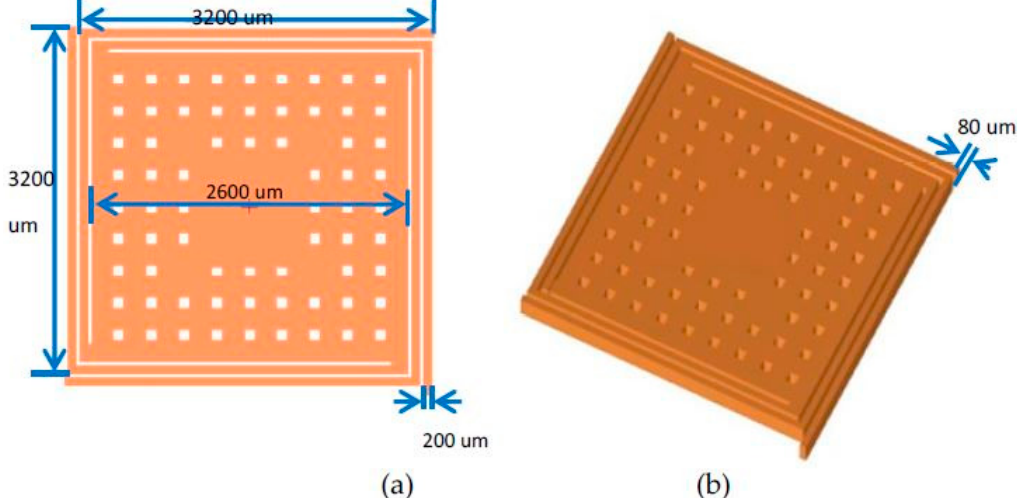
Figure 4. Structure of the sensitive structure of the vacuum microelectronic accelerometer. ( a ) Plan view of the sensitive structure; ( b ) 3D map view of the sensitive structure. Table 1. Key structure parameters of the sensor.